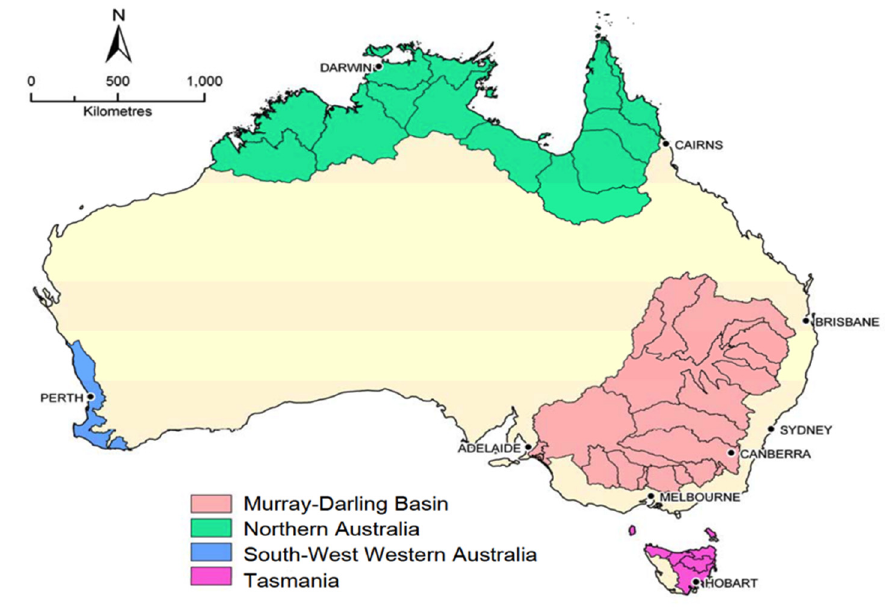
Figure 2. CSIRO “Sustainable Yield” Studies. Source: